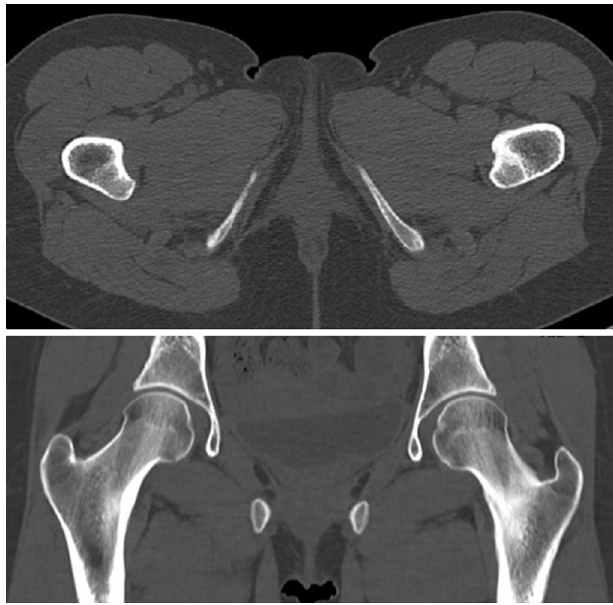
Figure 2. Pelvic CT-scan (A (cid:1) axial view, B (cid:1) coronal view) showing disruption of the medial cortex of left femoral